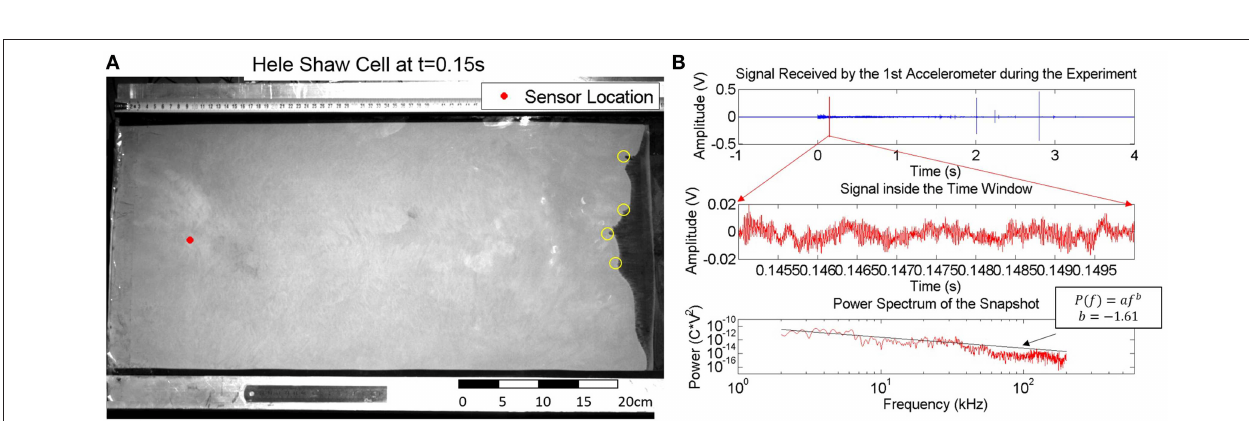
FIGURE 5 | Ambient Lab Noise recorded prior to experiment. The red strip in the top left panel (time window of 0.005s) and its zoomed version (Bottom left panel) corresponds to the snapshot that the power spectra (Right) occurred at. Right panel: The uncorrected (blue) and corrected with sensor response (red) power spectra of the ambient lab noise.